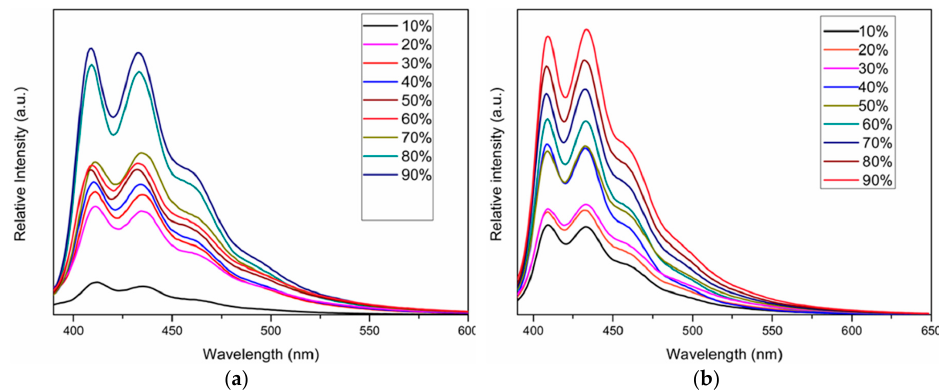
Figure 2. Emission spectra of IL-POSS-Br ( a ) and IL-POSS-Cl ( b ) (1 × 10 − 6 M).